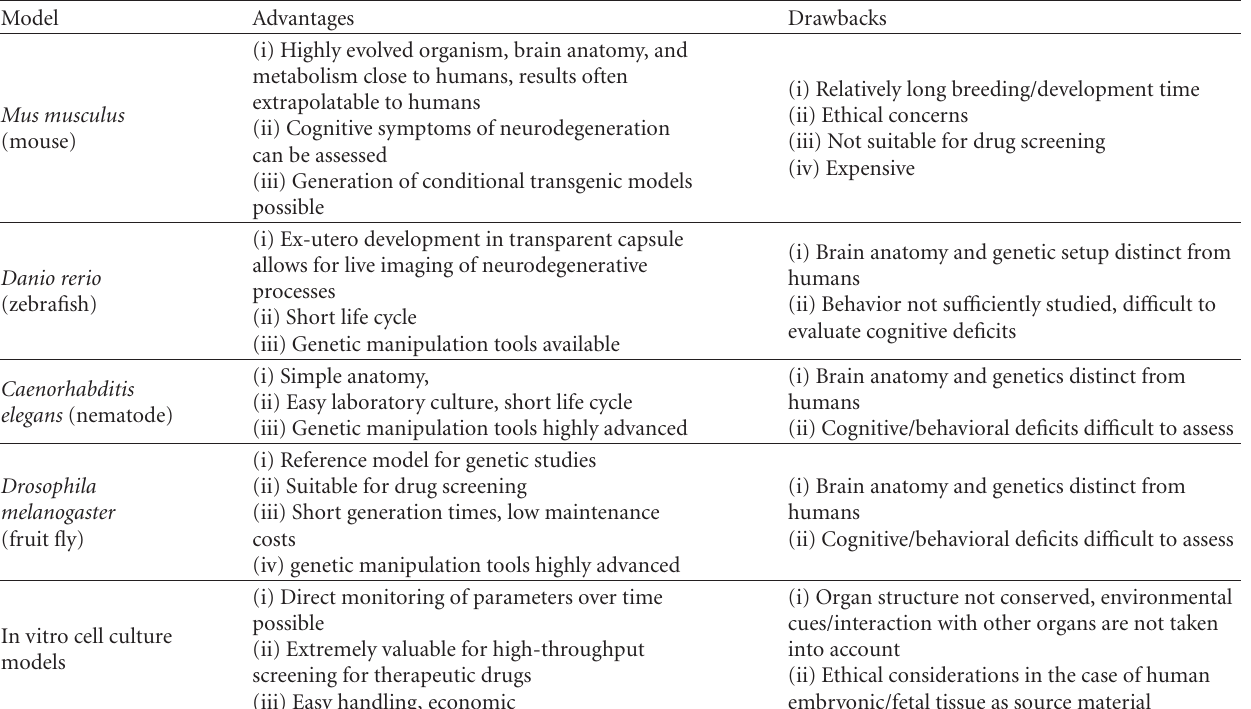
Table 1: Overview of the most widely used models for studying Alzheimer’s